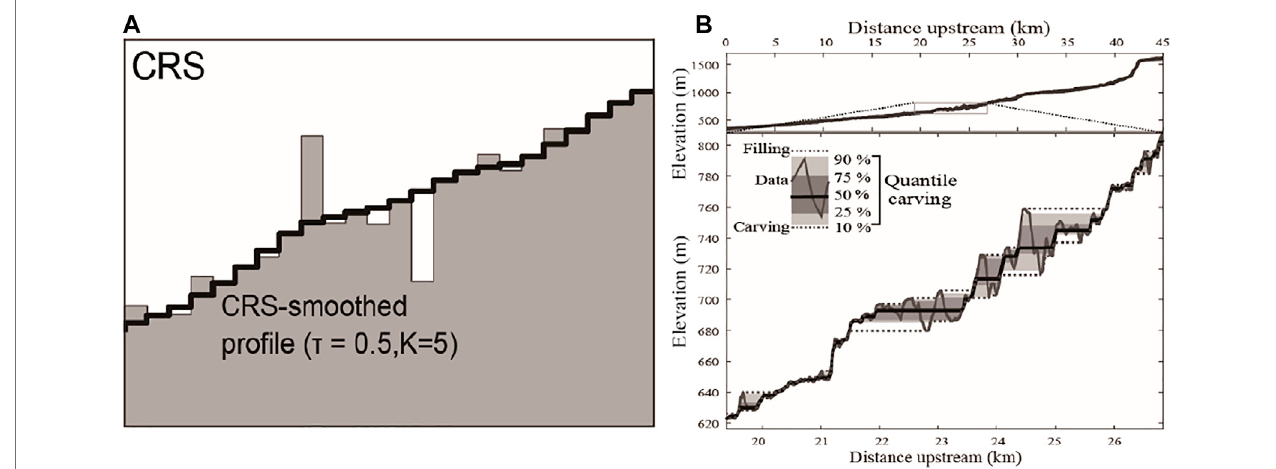
FIGURE4| Schematicdiagramsillustratingthemethodofsmoothingtheriverpro fi leusingtheapproachofSchwanghartandScherler(2017). (A) Smoothingusing the constrained regularized smoothing (CRS) method; (B) Quantile carving of the longitudinal pro fi le.